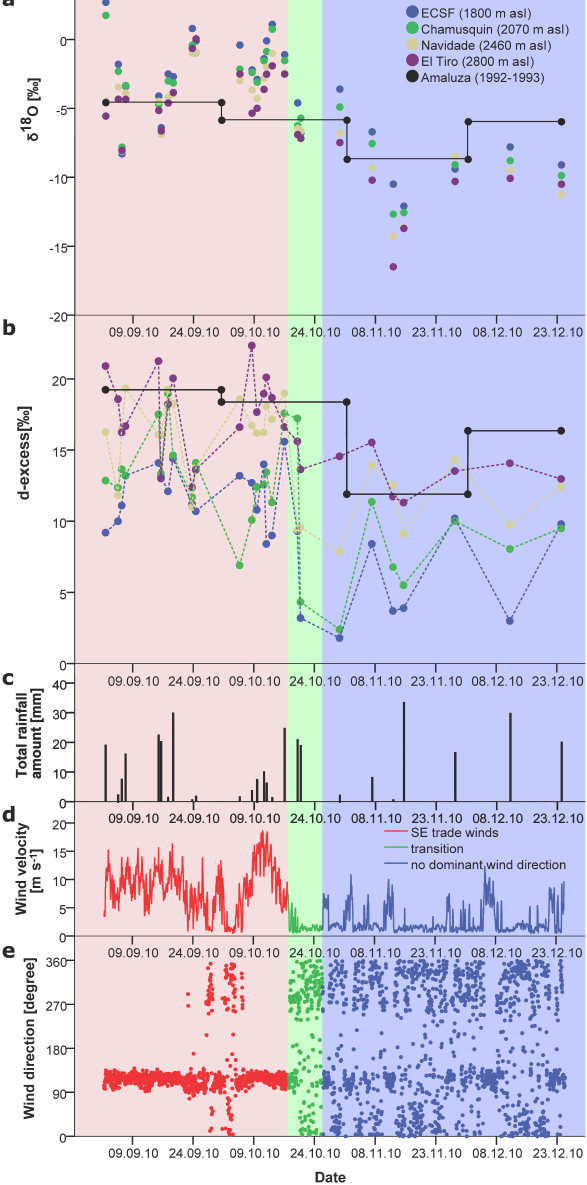
Fig. 2. Results of the 26 events sampled. (a) δ 18 O isotope sig- natures, (b) deuterium excess of all sampled events compared to weighted monthly means from GNIP station Amaluza from 1992– 1993, (c) total amount of rainfall for each event, (d) wind velocity and (e) wind direction for the investigated period recorded at the El Tiro climate station. For (a) and (b) the different measurement sta- tions are color coded. For (d) and (e) the colors indicate the 3 dif- ferent climate